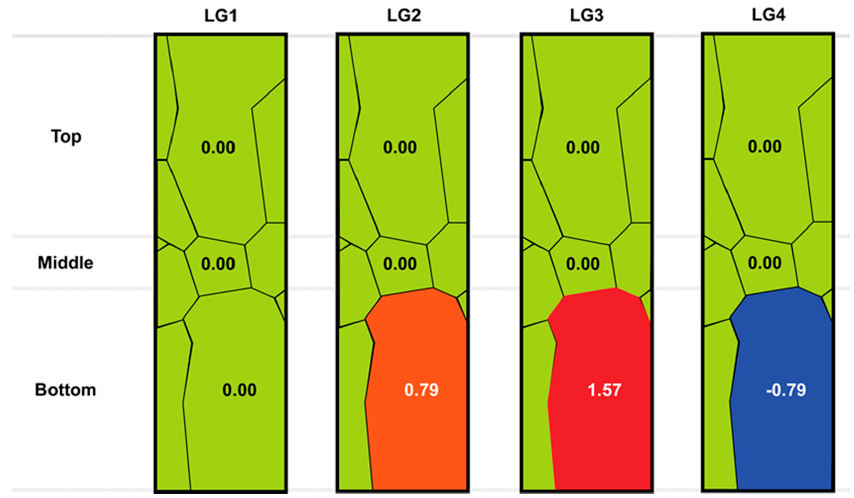
Figure 10. The grain orientations of the four considered cases (LG1 to LG4).